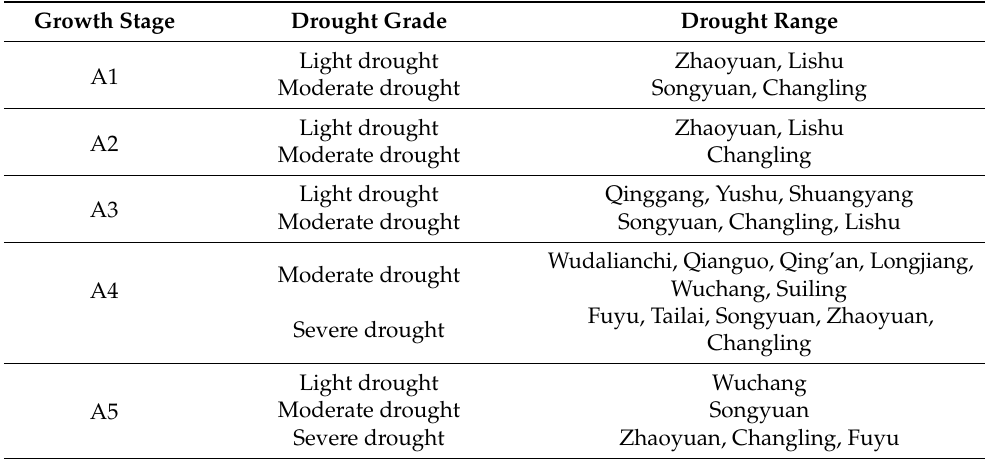
Table 1. Drought disasters of spring maize in Songnen Plain in typical drought years. Growth